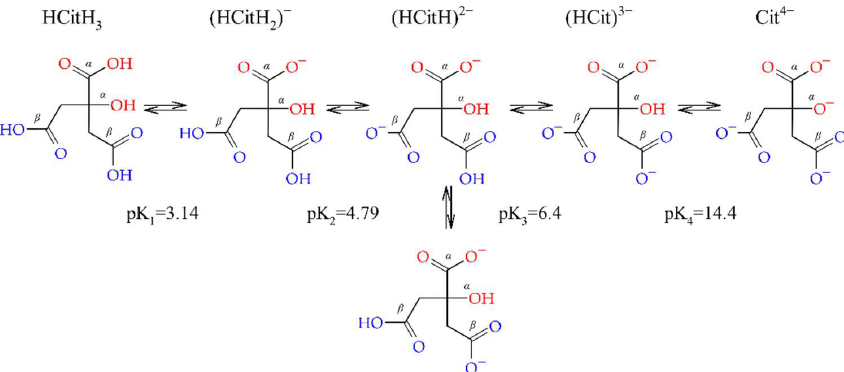
Figure 1. Citric acid deprotonation, adapted from Heller et al. [32], and average pK a values at 20 °C [31,33,34].